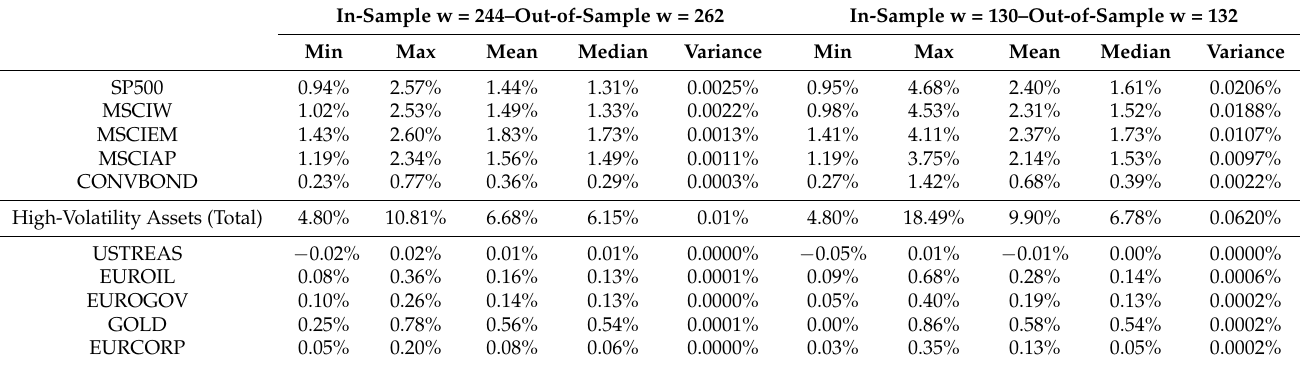
Table 7. Assets’ marginal risk contributions (MRCs).